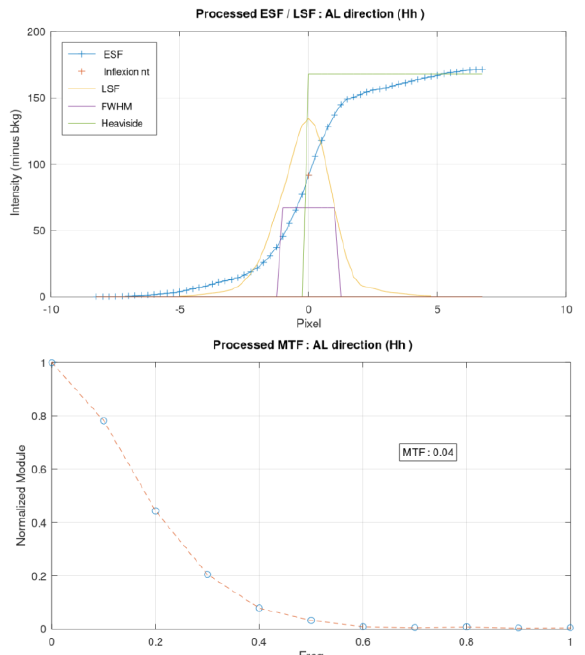
Figure 3. The ESF, LSF, FWHM, SNR, RER and MTF results over the Hh direction (along-track) from the pan band in Salon- de-Provence.